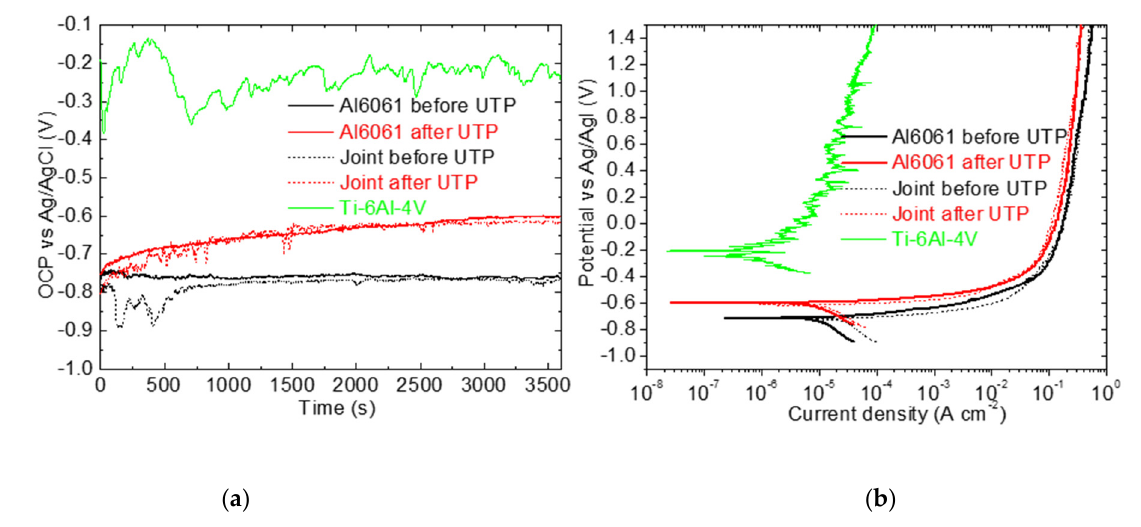
Figure 16. ( a ) Open circuit potential and ( b ) potentiodynamic polarization curves of AA6061 before and after UPT, 3B joint before and after UPT, Ti-6Al-4V samples tested in 3.5% NaCl solution. Table 5. Corrosion potential and corrosion current density extracted from potentiodynamic polariza- tion curves reported in Figure 16b.